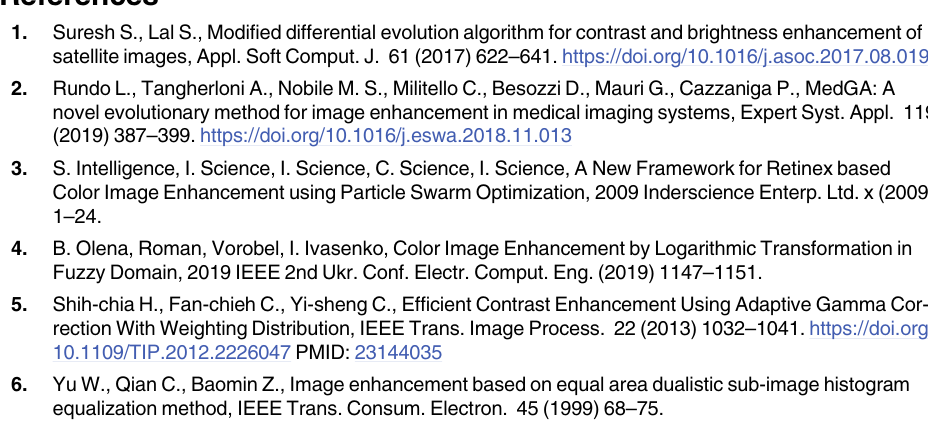
S1 Table. Relevant data underlying the findings described in Table 2. S2 Table. Relevant data underlying the findings described in Tables 10 and 16. S3 Table. Relevant data underlying the findings described in Tables 5–9 and 11–15. S1 Fig. Relevant data underlying the findings described in Figs 4,